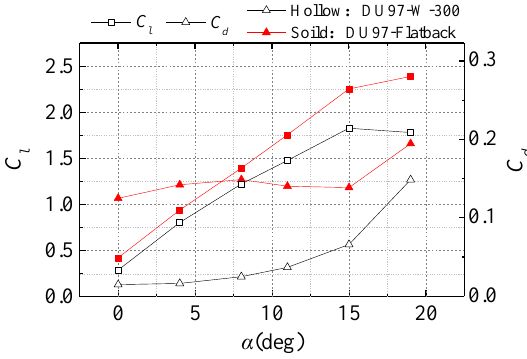
Figure 8. Distribution of airfoil lift and drag coefficient.